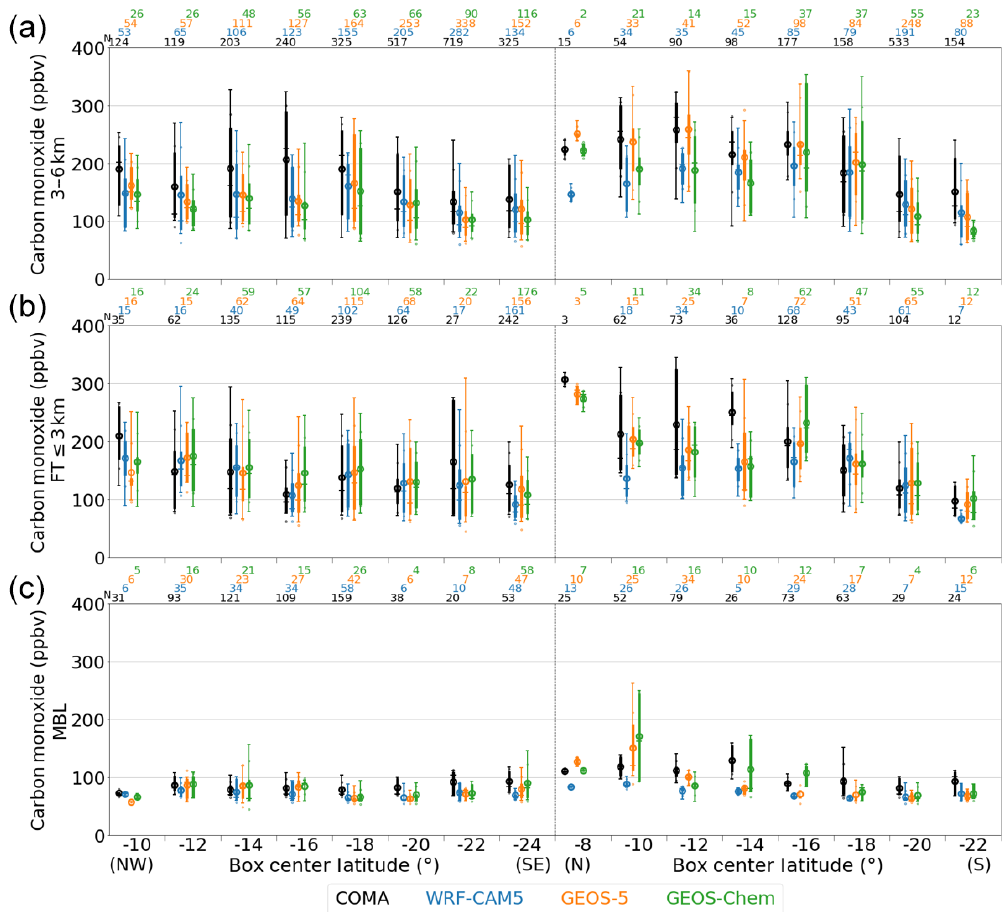
Figure 8. Same as Fig. 6 but for carbon monoxide mixing